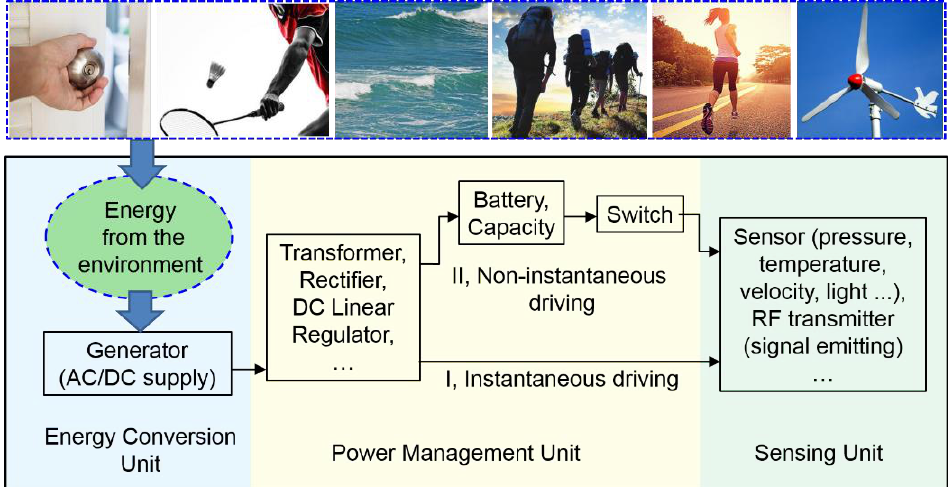
Figure 1. Block diagram of a self-powered sensing system and its working